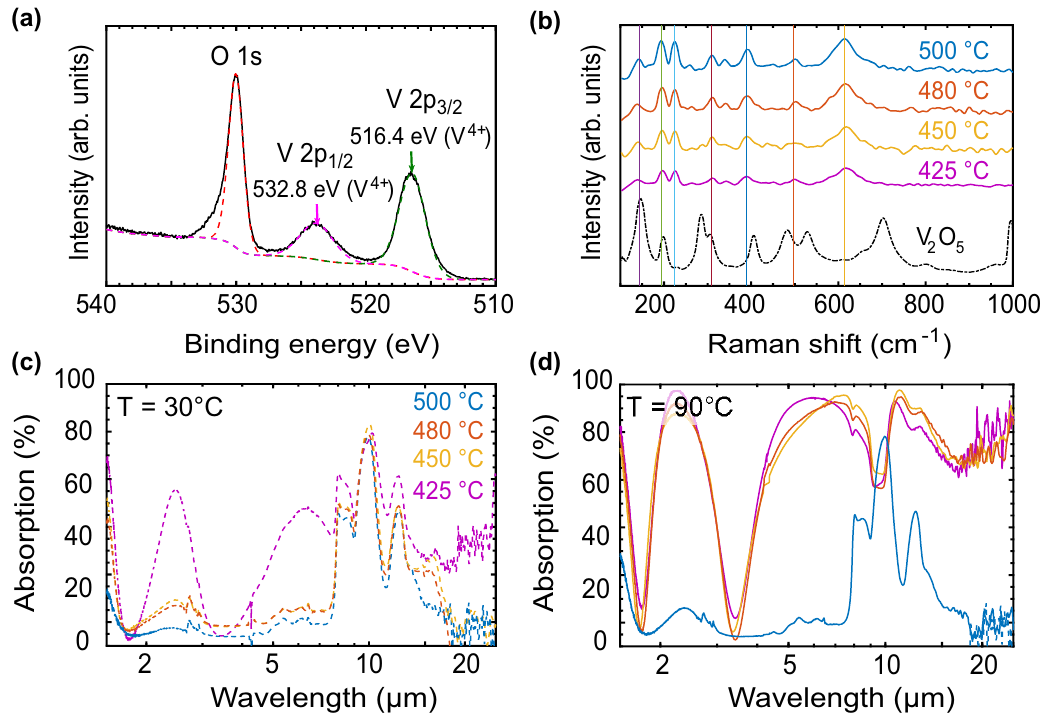
Figure 4: VO 2 by atomic layer deposition process and the characterizations after different post-anneal treatments. (a) X-ray photoelectron spectroscopy (XPS) result showing key energies corresponding to the VO 2 phase. (b) Raman spectra of VO 2 with 1 h anneal at temperatures of 425 ° C, 450 ° C, 480 ° C and 500 ° C. (c and d) FTIR absorption spectra of VO 2 /SiO 2 /Al stack measured at 20 ° C (dashed lines, c) and 90 ° C (solid lines, d) for the annealed samples of